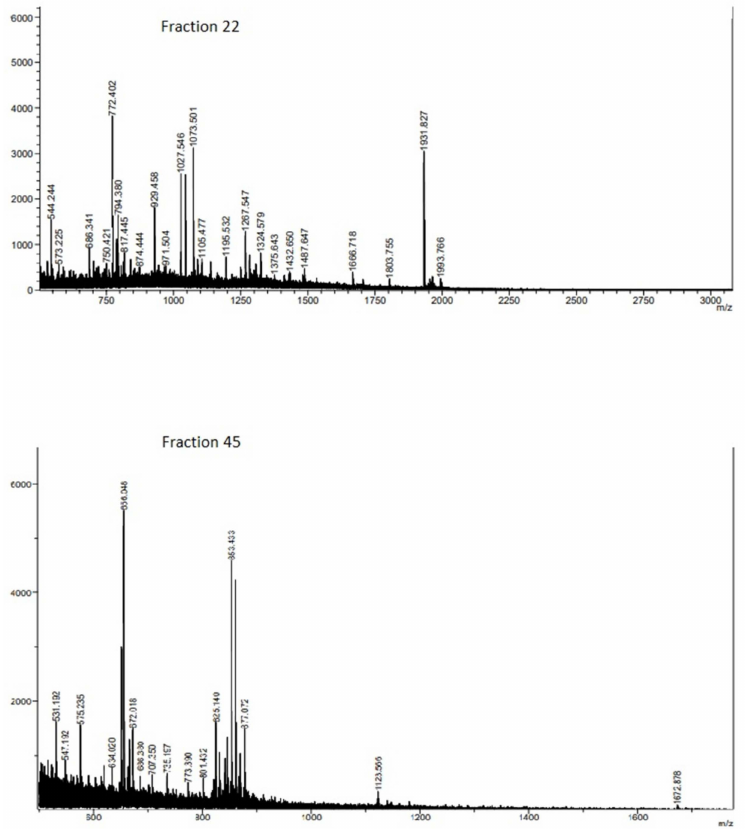
Figure 2. Fraction 22 and 45 MALDI-TOF mass Spectra.